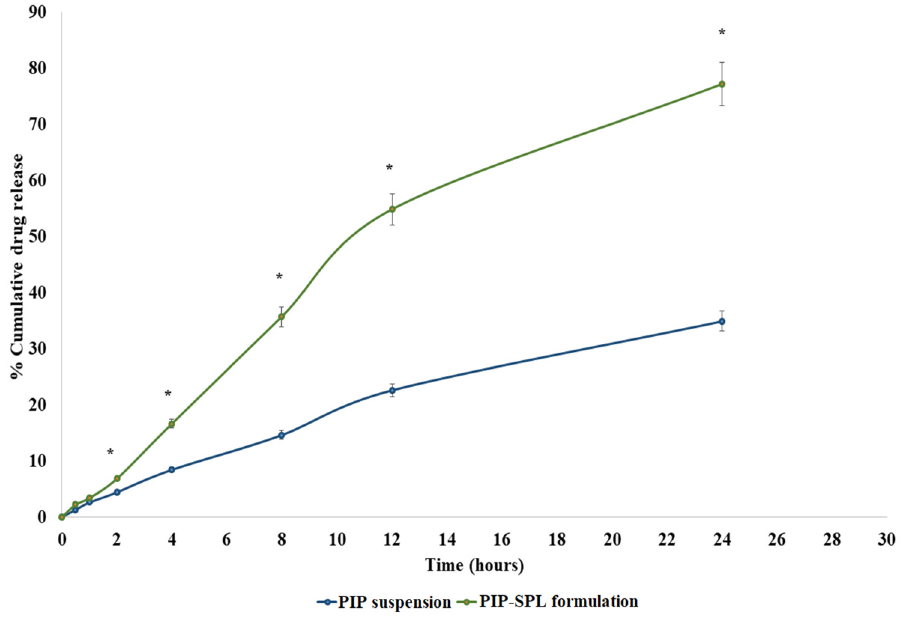
Figure 5. Comparative in vitro skin permeation study of PIP suspension and PIP-SPLopt formula- tion across goat nasal mucosa membrane. *: statistically significant at p ≤ 0.05. across goat nasal mucosa membrane. *: statistically significant at p ≤